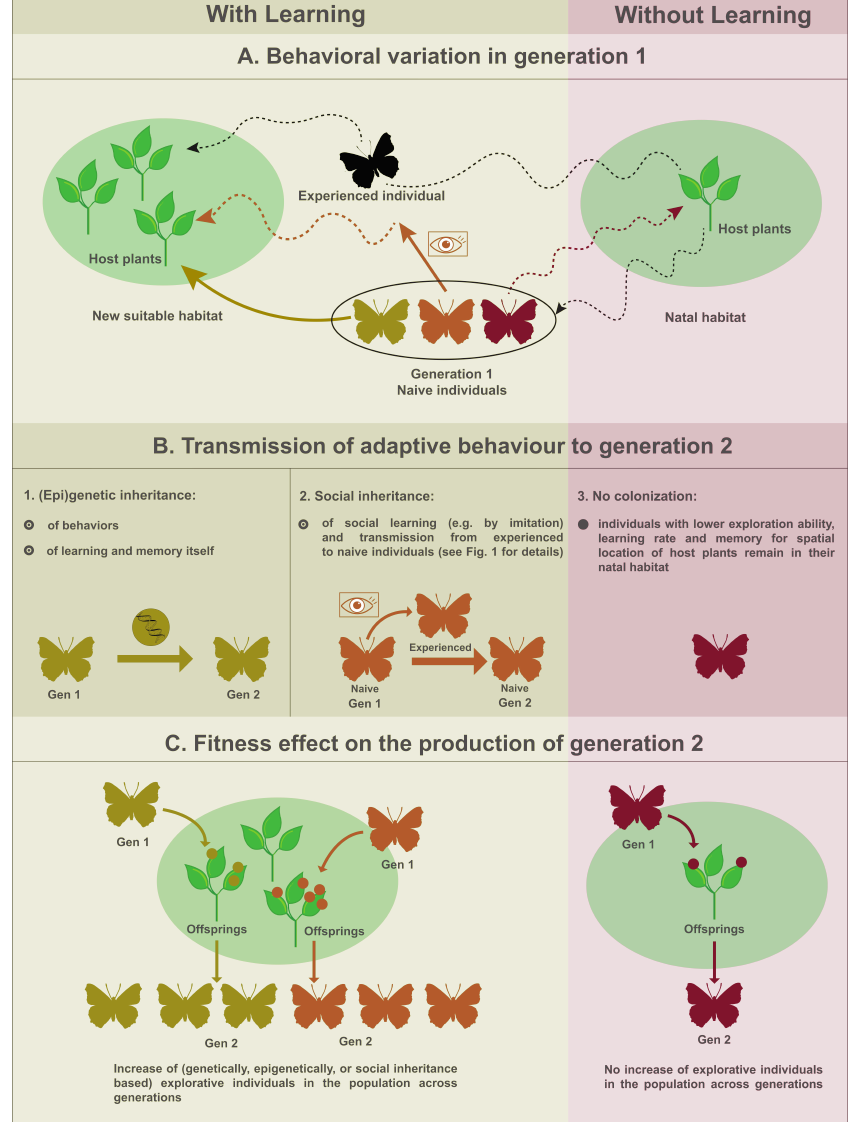
Figure 2. (Epi)genetic and social inheritance for oviposition site selection can affect the colonization of new suitable habitats with better host plant resources. A : Variation between individuals in oviposition site selection on host plants can be due either to (epi)genetic variation or variation in social learning skills. Social learning can lead to the colonization of new suitable habitats by naive individuals, for example by following experienced individuals towards a new habitat patch. Here, social learning is based on imitation and can occur through horizontal, oblique or (more rarely so) vertical transmission. Individuals not relying on social learning from conspecifics have a lower probability of finding new suitable habitats for oviposition. B : More adaptive behavioral variants for finding a new suitable habitat for oviposition can be transmitted through genetic or (epi)genetic variants (1). Transmission of social learning ability from parents to offspring can be genetically based or (epi)genetically transmitted. In addition, social learners outperform individuals not using social cues to learn about resource distribution in their environment (2). Social inheritance allows younger individuals to locate new habitats based on social information provided by older conspecifics. When there is no (epi)genetic basis for exploration, and learning and social learning does not occur, individuals have a lower probability of colonizing new habitats (3). C : The increasing ability of individuals within a population to learn and remember the spatial location of resources, such as host plants for oviposition, can be due to selection of (epi)genetic variants of the adaptive behavior, including learning rate and memory retention, or due to social transmission of the spatial location of resources from older to younger individuals leading to social inheritance. The accumulation of advantageous modifications of behavior in populations across generations may produce differential local adaptation between populations in socially learned traits, based on local environmental conditions and geography in much the same way as local adaptation through genetic differentiation